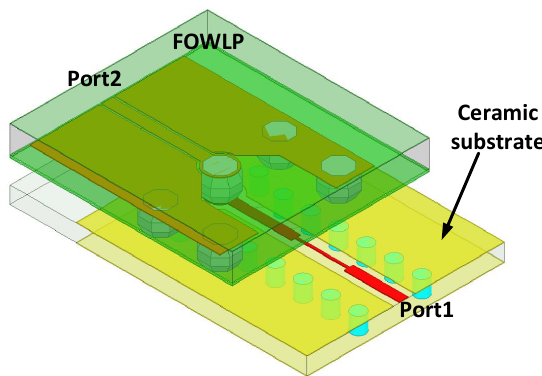
Figure 3. Three-dimensional simulation model for the package-board